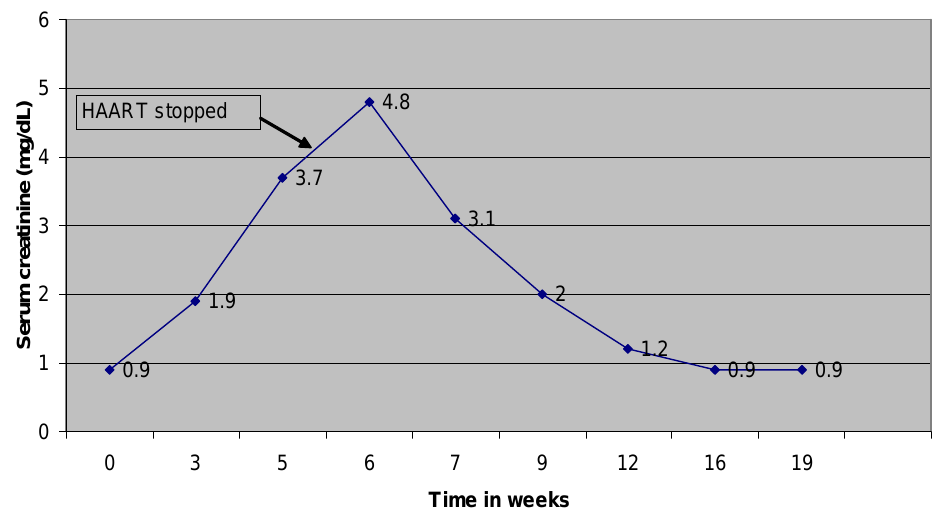
FIGURE 2. Renal function in patient receiving tenofovir-containing